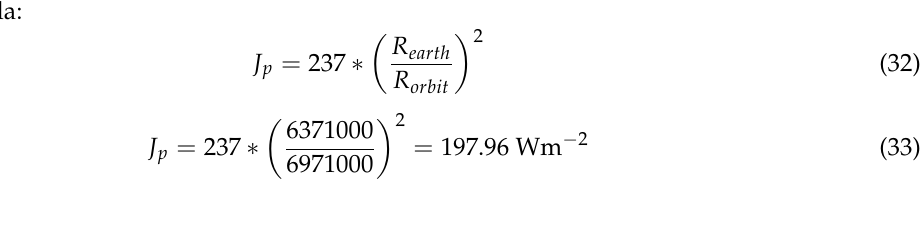
Figure 47. Fluctuations in Earths IR Output throughout an Orbit Cycle [64].